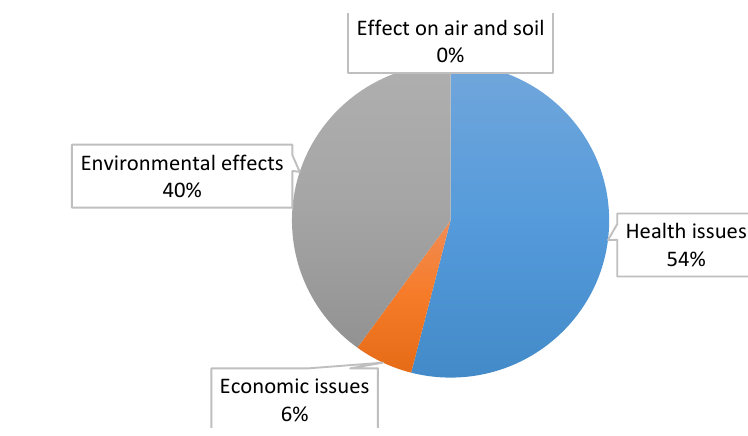
Figure 4. Prioritization in selecting the appropriate method of decontamination of decentralized health waste